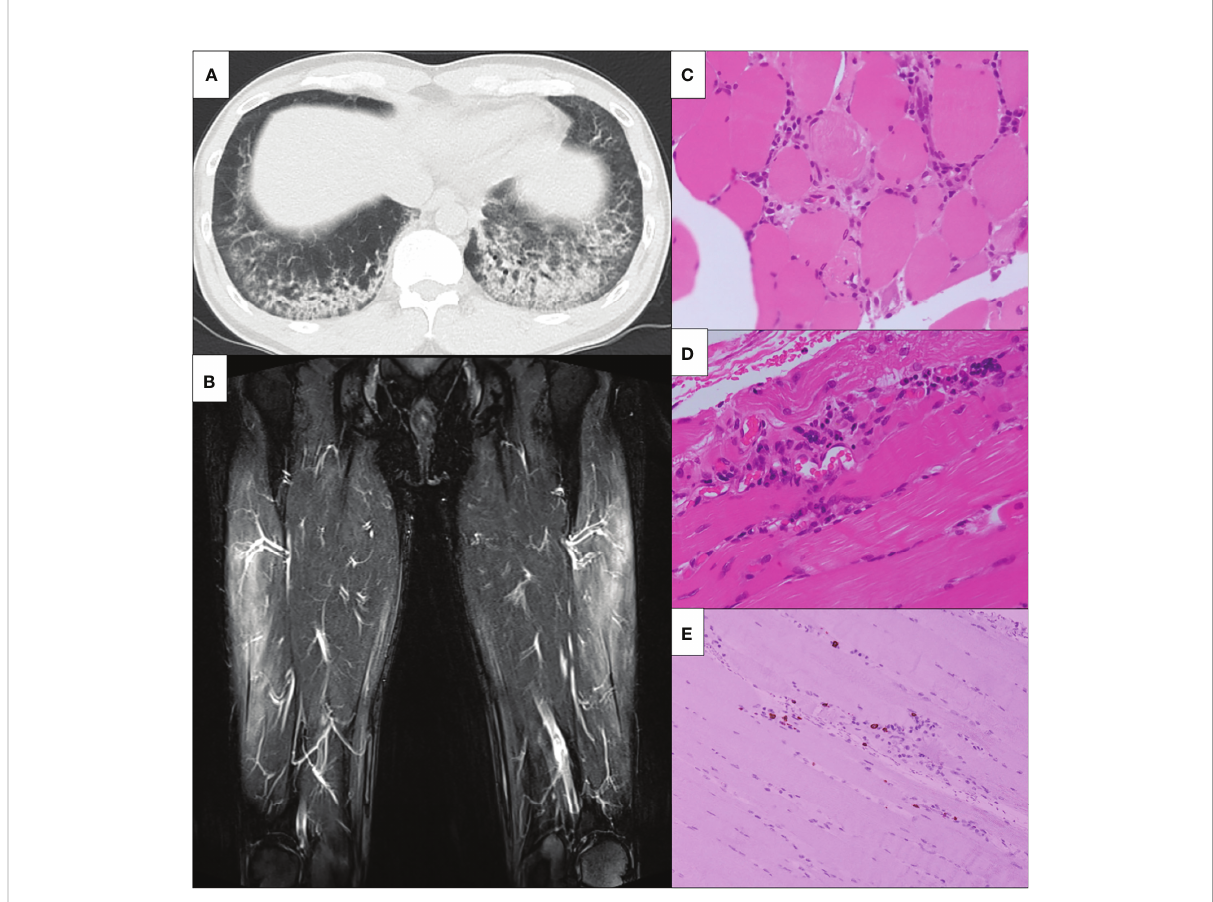
FIGURE 2 Clinical imagings. (A) Chest non-contrast CT fi ndings. Chest non-contrast CT revealed bilateral ground-glass opacity. (B) MRI fi ndings of bilateral lower limbs. MRI shows high signals on STIR in the bilateral vastus lateralis, suggesting muscular in fl ammation. MRI, magnetic resonance imaging; STIR, short T1 inversion recovery. (C-E) The slide showed (C) in fl ammatory cell in fi ltration around the myo fi ber bundles, (D) perivascular in fl ammatory cell in fi ltration, and (E) CD8-positive lymphocytes in fi ltration in atrophy of the myo fi bers. CT, computed tomography; HE, hematoxylin-eosin; MRI, magnetic resonance imagin; STIR, short T1 inversion recovery; CD, cluster of